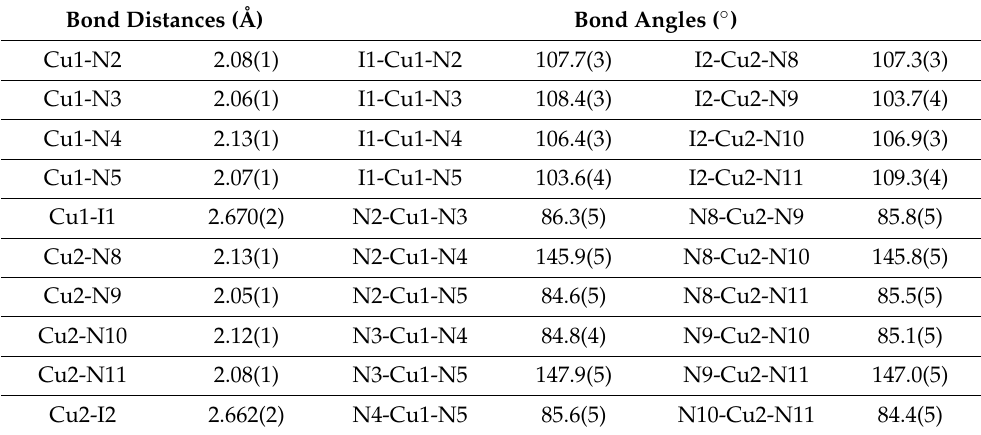
Table 2. Bond distances and angles defining the Cu(II) coordination environment in the crystal structure of [Cu(L)I] 2 I 3 I 5 .